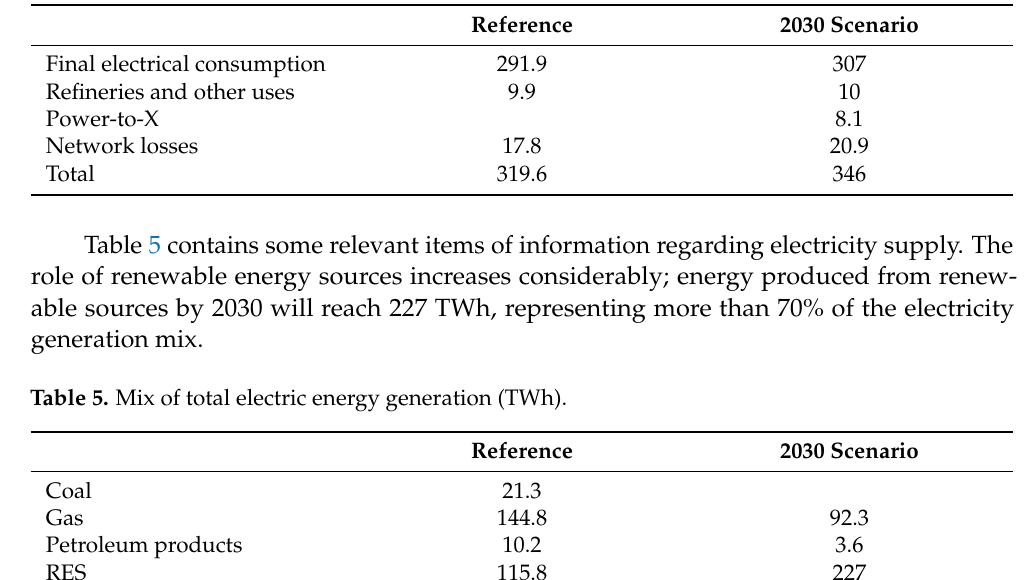
Table 4. Network electric demand (TWh).